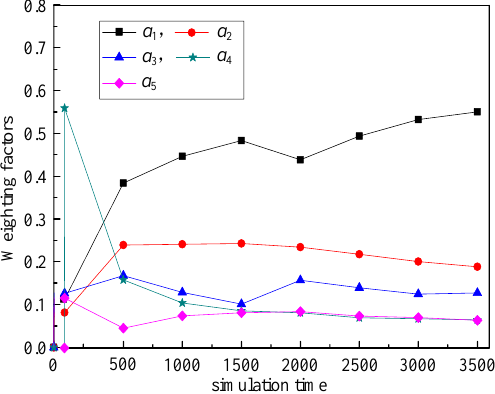
Figure 11. Relationship between weighting factors and simulation time: node 100.